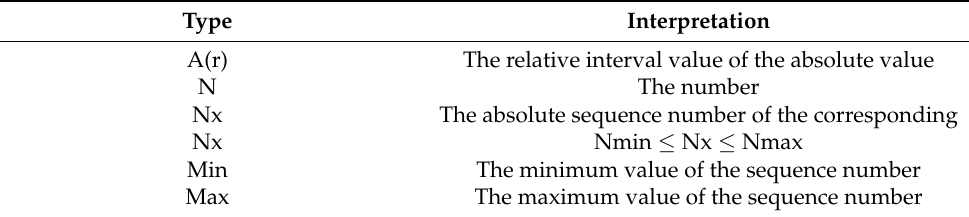
Table 2. The relative value calculation formula